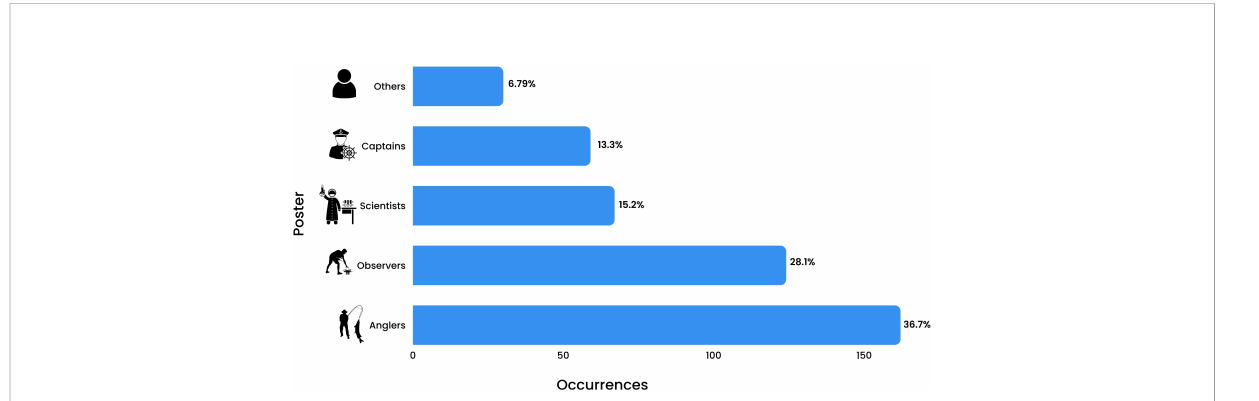
FIGURE 1 Number of occurrences and percentages of Instagram posts in saw fi sh-related hashtags who encountered the smalltooth saw fi sh from August 2018-August